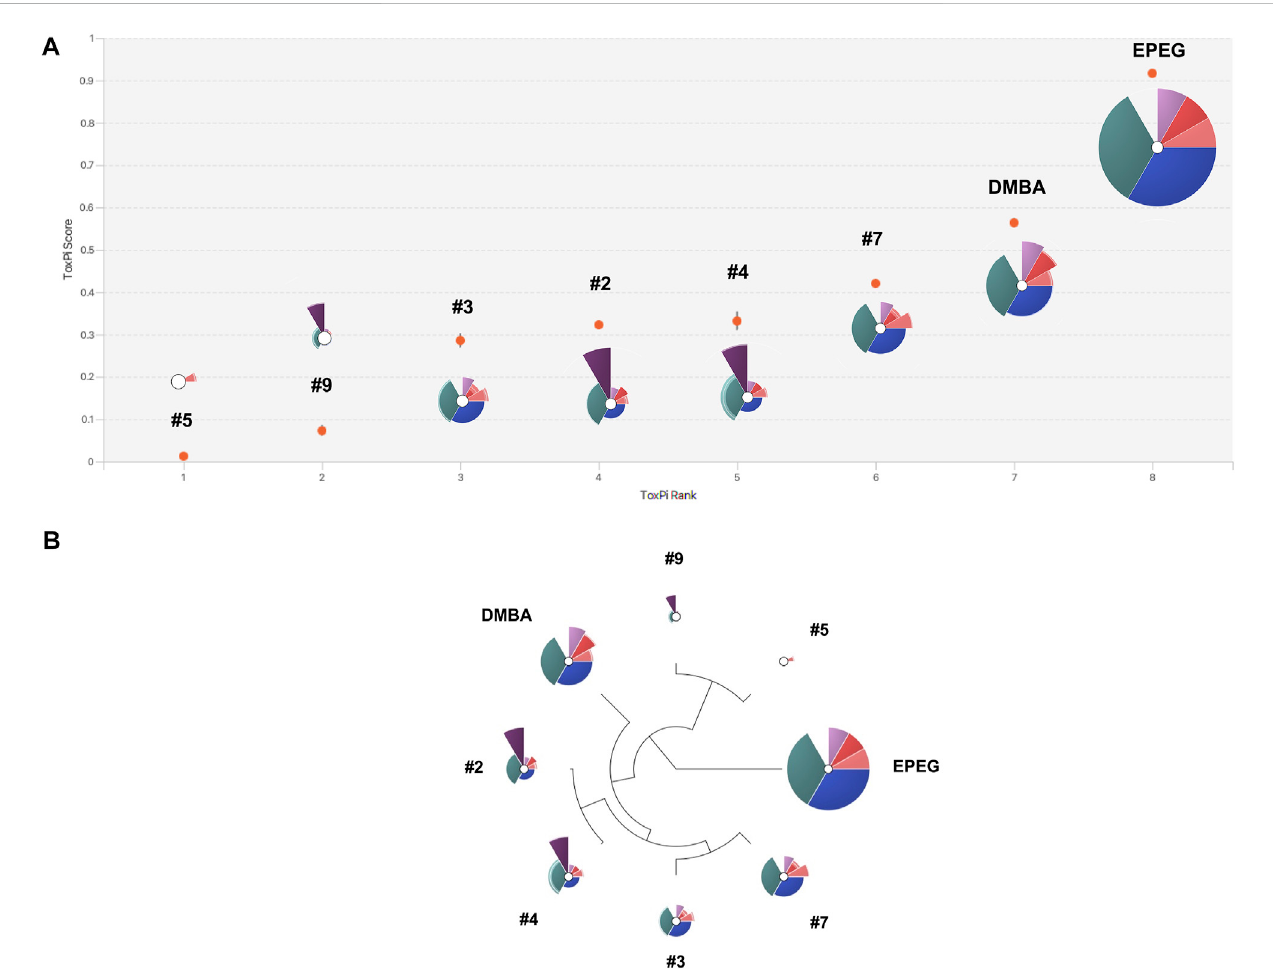
FIGURE 5 ToxPi visualization of multiplexed BMCs for the NSACB compounds with concordant positive hazard fl ags. (A) ToxPi score rankings and pro fi les for the data-poor compounds. For the ToxPi pro fi les, the distance of each slice from the origin indicates the slice score and endpoint potency (i.e., − log10 BMC). Slices represent the following endpoints: teal is TGx-DDI BMC, blue is MicroFlow ® BMC, pink and purple are the MultiFlow ® BMCs (i.e., dark pink is 24H p53, light pink is 4H p53, dark purple is 24H ɣ H2AX, light purple is 4H ɣ H2AX). Lower and upper bound con fi dence intervals are indicated by lighter shaded areas at the periphery of each slice. The width of each slice indicates the assigned endpoint weight. The TGx-DDI, MicroFlow ® , and combined MultiFlow ® endpoints each represent 1/3 of the pro fi le. (B) Hierarchical clustering of the ToxPi pro fi les. The ToxPi algorithm groups substances with similar toxicological pro fi